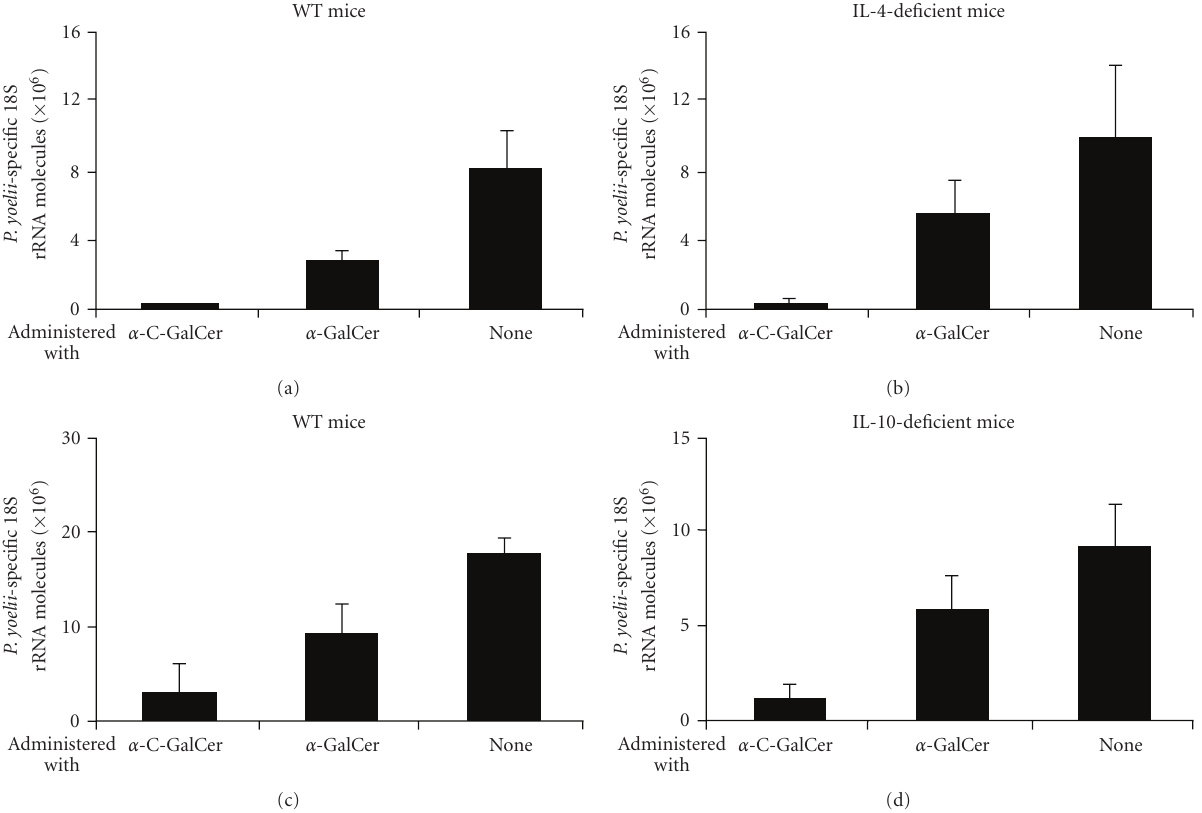
Figure 3: α -C-GalCer’s superior antimalarial activity does not involve IL-4 or IL-10. (a) Groups of 5WT or IL-4-deficient BALB/c mice, or (b) groups of 5WT or IL-10-deficient C57BL/6 mice, were treated i.p. with 1 μ g of either α -C-GalCer or α -GalCer or with nothing 3 days before challenge with live P. yoelii sporozoites, and then checked for malaria liver stage development. The results are expressed as the average + / − SD of 5 mice. The data shown come from one of three experiments with similar